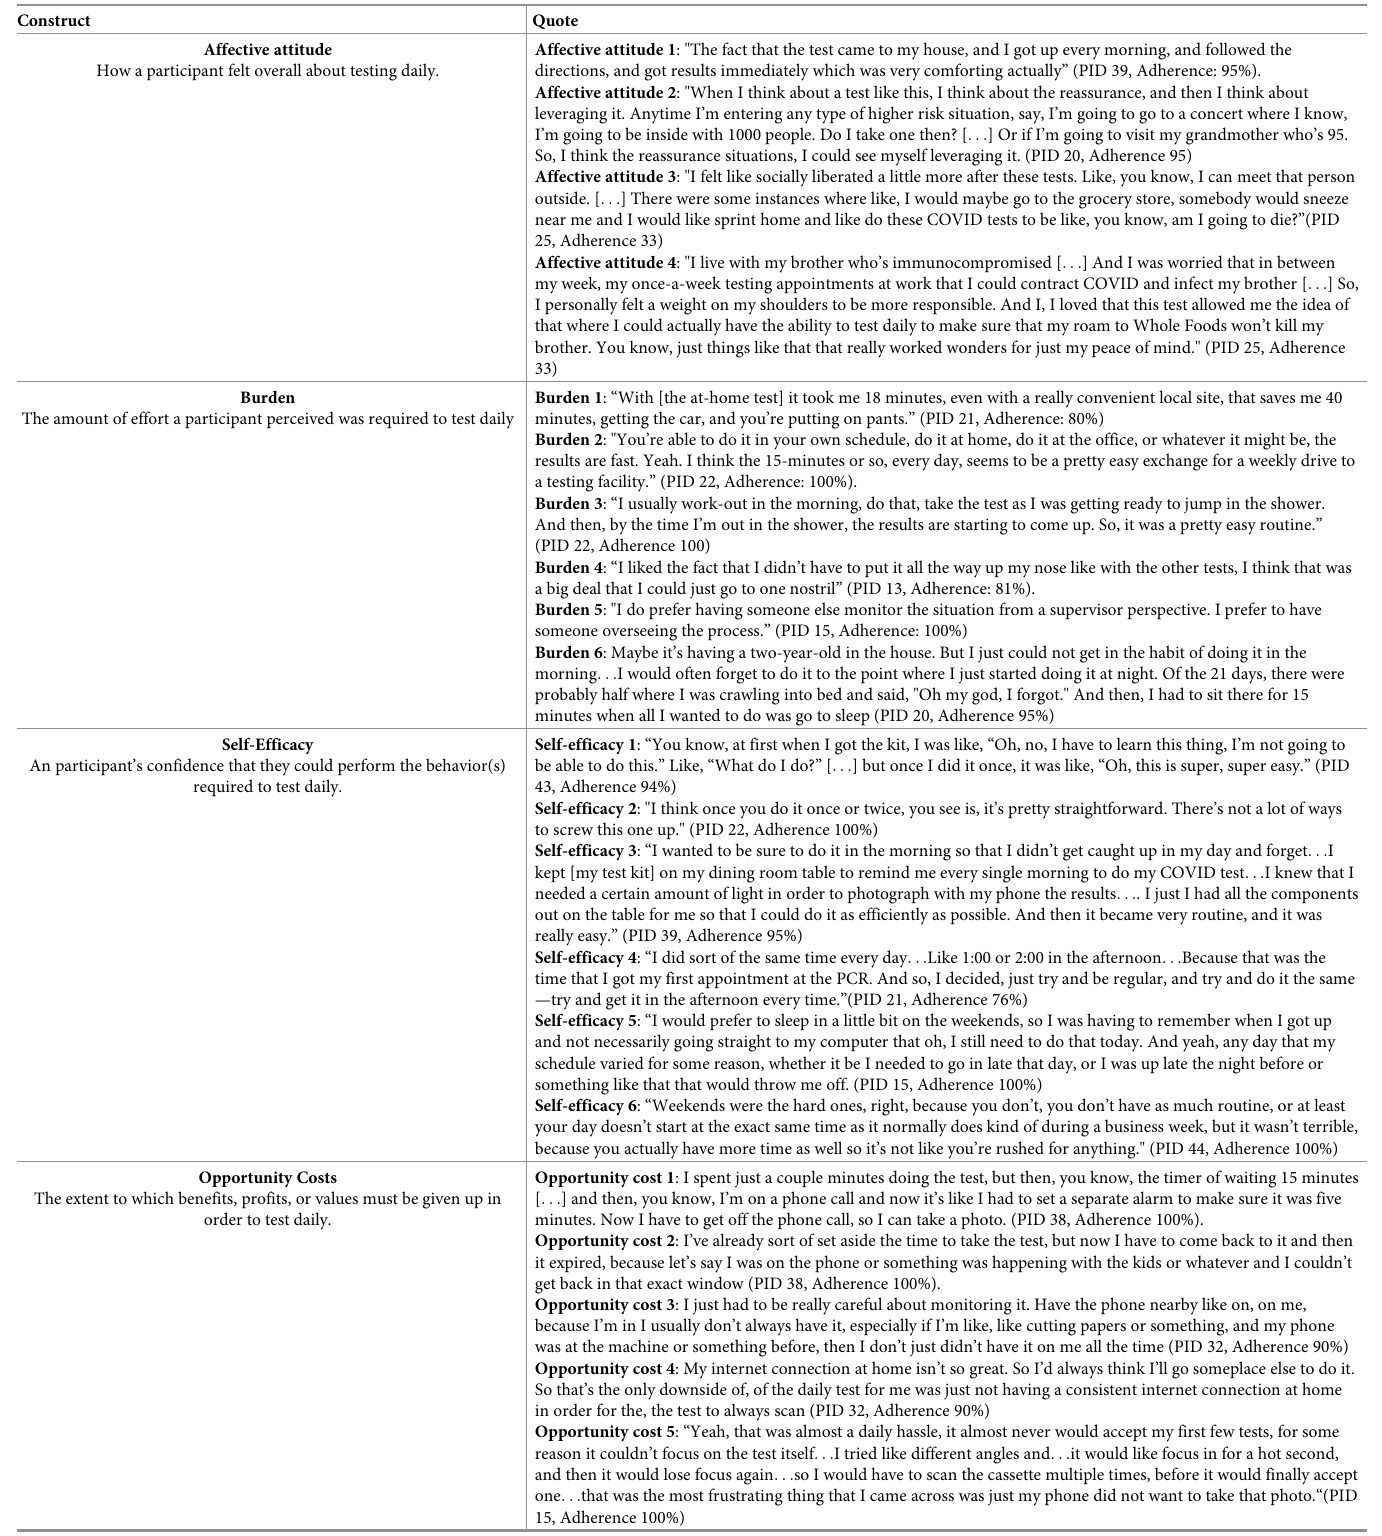
Table 4. Acceptability of a COVID-19 daily antigen testing regime in an employment context according to Sekhon’s seven domains of acceptability. Construct Quote Affective attitude How a participant felt overall about testing